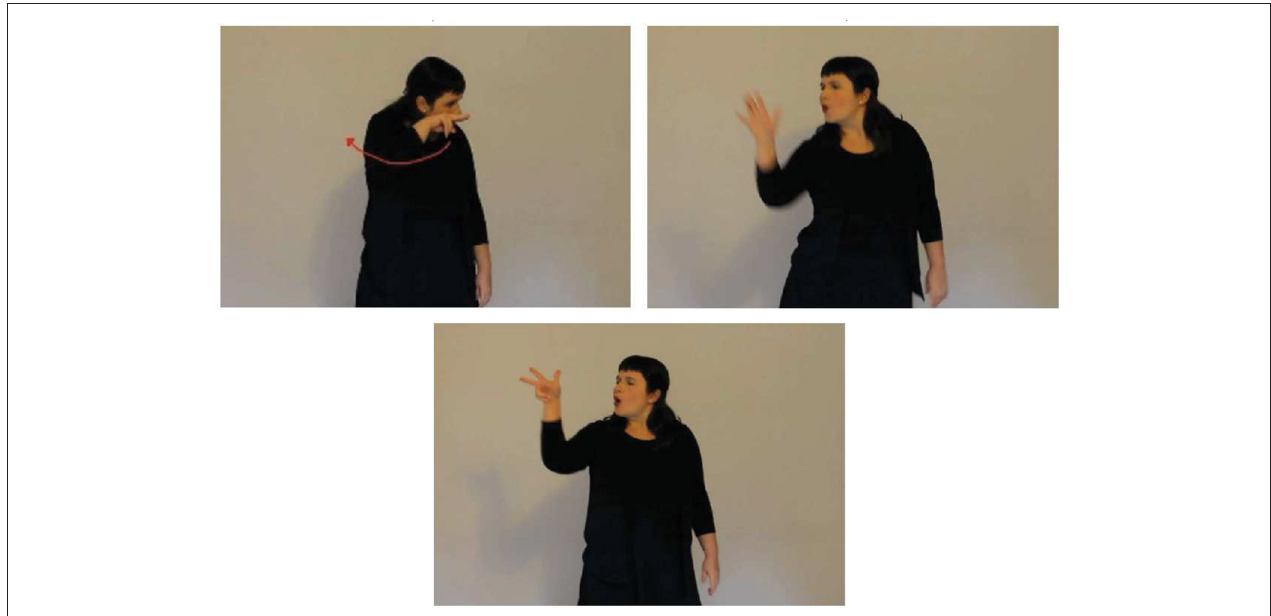
FIGURE 2 | Our translation of “E come il vento // Odo stormir tra queste piante.” (“And when I hear / the wind stir in these